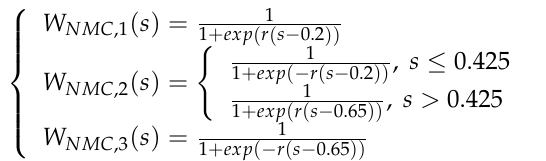
Table 1. Sub-models of NMC battery.